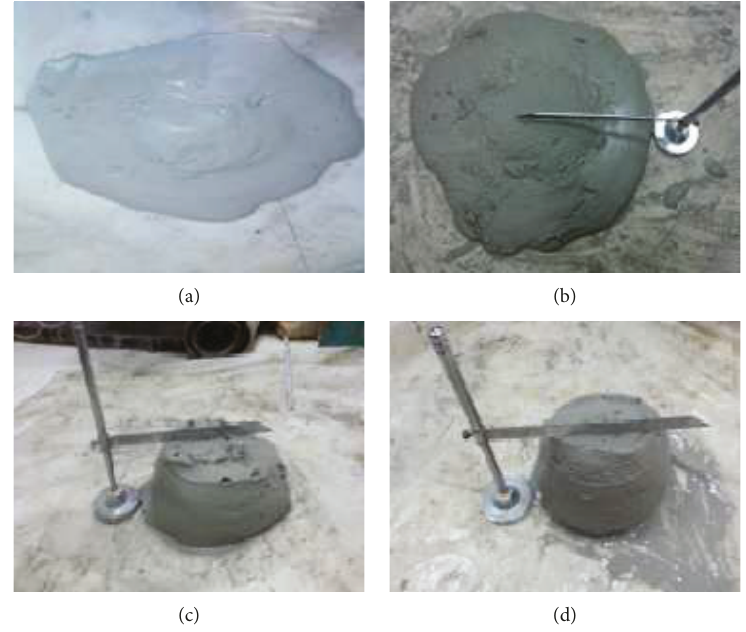
Figure 9: Results of slump tests at mass fractions of (a) 65%, (b) 68%, (c) 70%, and (d) 72%.